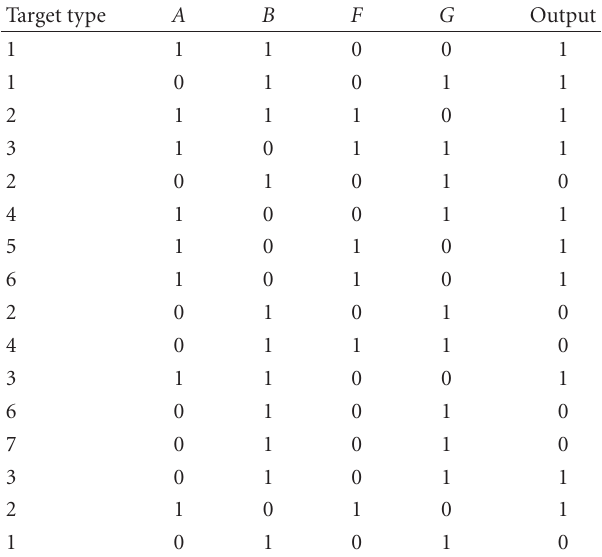
Table 5: Original visual scene data, after Boolean quantization, and after factor